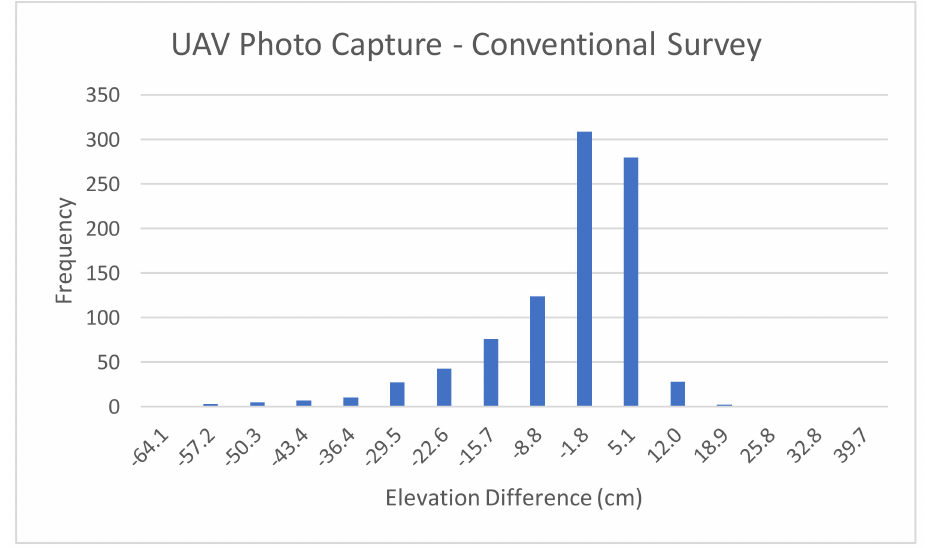
Figure 7. Elevation Di ff erence Between UAV Photogrammetric Capture and Conventional